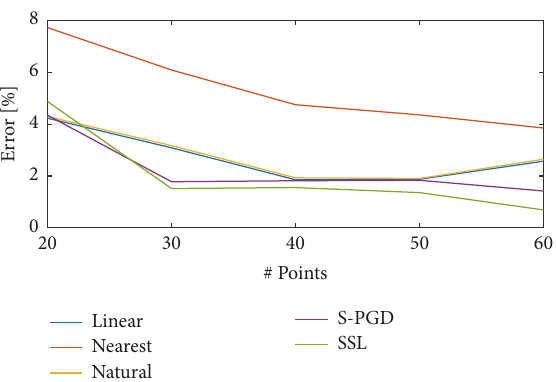
Figure 6: E L of 𝑓 2 (𝑥, 𝑦) varying # P for different identification techniques. # L = 1000 .